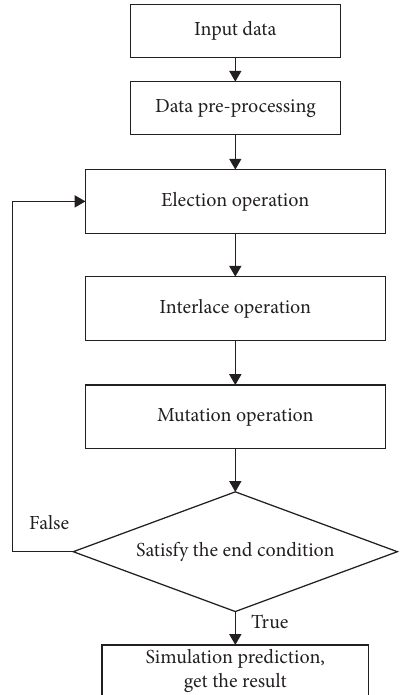
Figure 5: Flow chart of C-means